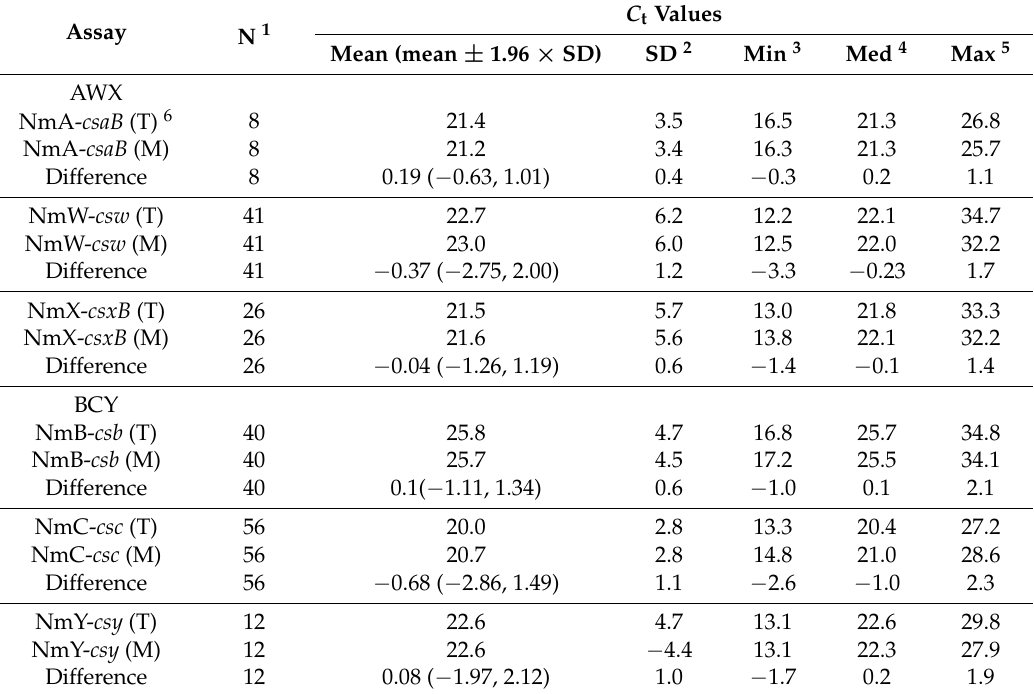
Table 2. Summary statistics from a pairwise comparison of C t values between triplex (T) and monoplex (M) meningococcal serogroup real-time PCR assays, directly testing on positive cerebrospinal fluid (CSF)